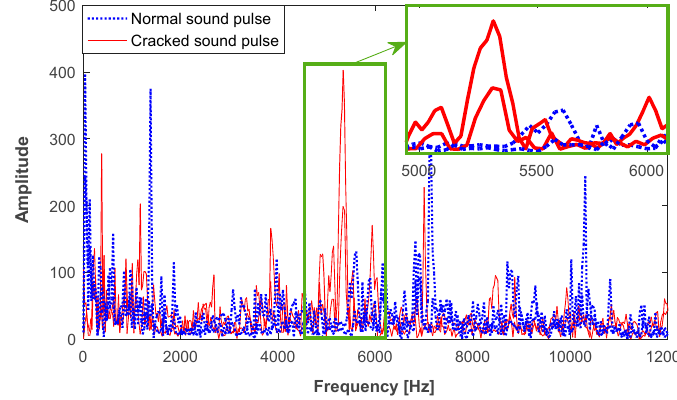
Figure 3. Frequency representation of the cracked sound pulses in combination with normal ones.